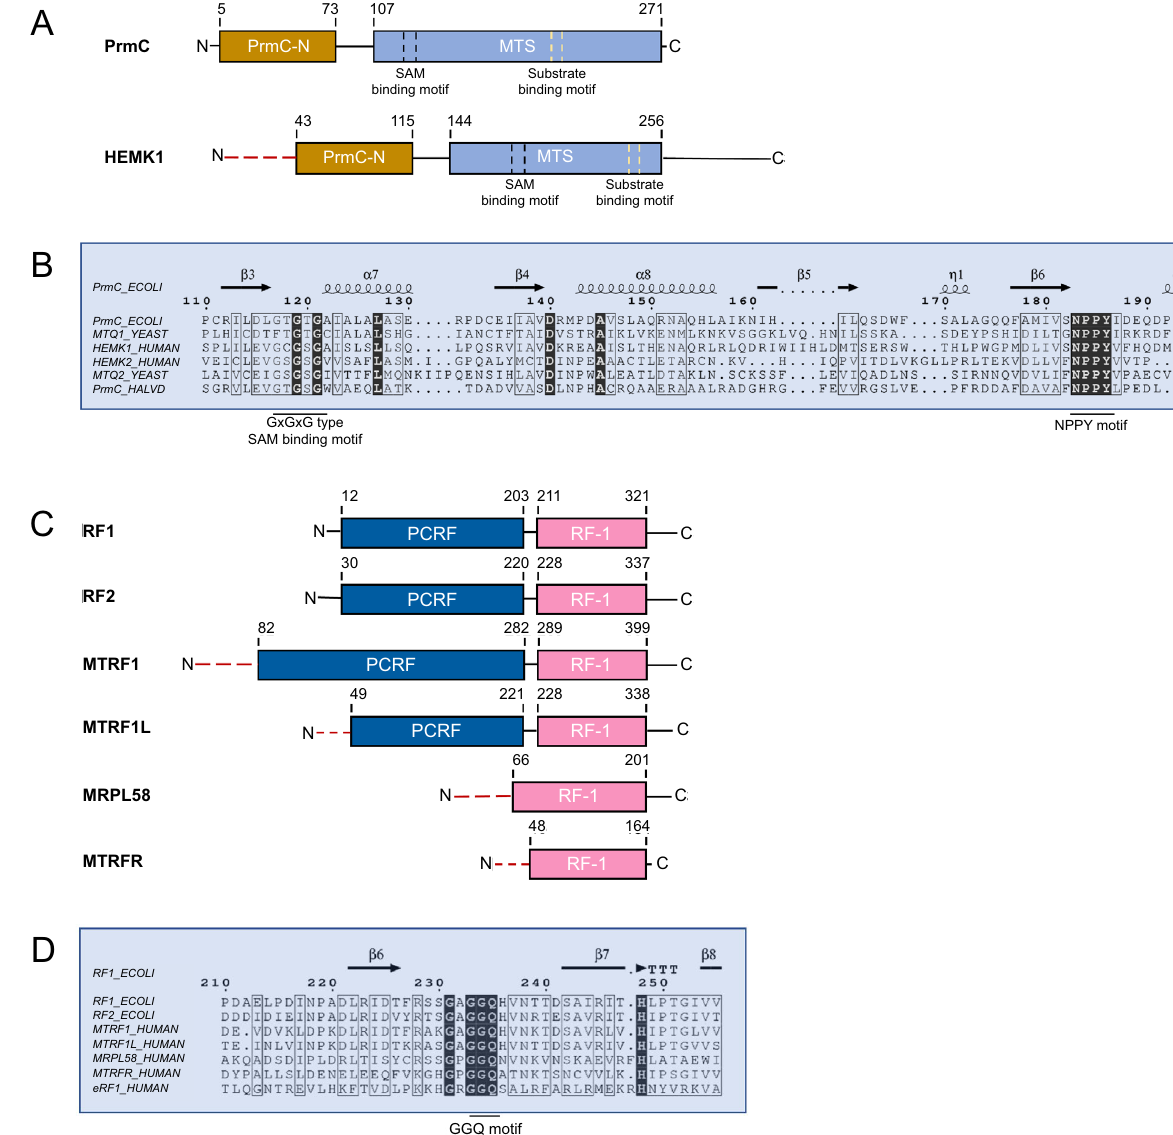
Figure 1. Domain architecture and sequence alignment of HEMK1 and mtRFs. ( A ) Domain architecture of PrmC and HEMK1. The red dash line indicated the predicted mitochondrial localization signal. PrmC-N: PrmC N-terminal domain (PF17827); MTS: methyltransferase small domain (PF05175). ( B ) Sequence alignments of various PrmC family proteins. The amino acid position is numbered according to the PrmC sequence. PCRF: peptide chain release factor domain, bacterial Class 1 (PF03462). RF-1: peptide chain release factor, bacterial Class I, PTH domain (PF00472). ( C ) Domain architecture of bacterial RF1, RF2, and mtRFs. The red dash lines indicated the predicted mitochondrial localization signal. ( D ) Sequence alignments of bacterial RF1, RF2, mtRFs, and the human eRF1. The amino acid position is numbered according to the bacterial RF1